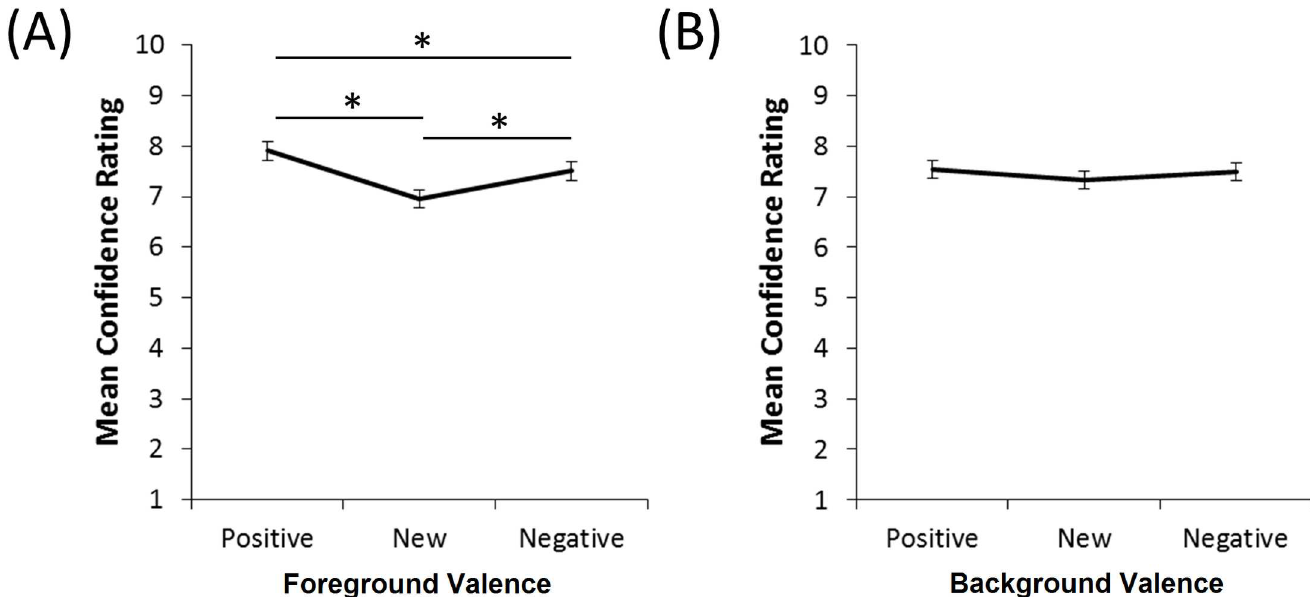
Fig 8. Confidence ratings. (A) Participantswere significantly more confidentin their responses to positive and negative objects than to new objects. (B) Confidenceratings did not differ as a function of contextualvalence.Asterisks indicatesignificantwithin-subject